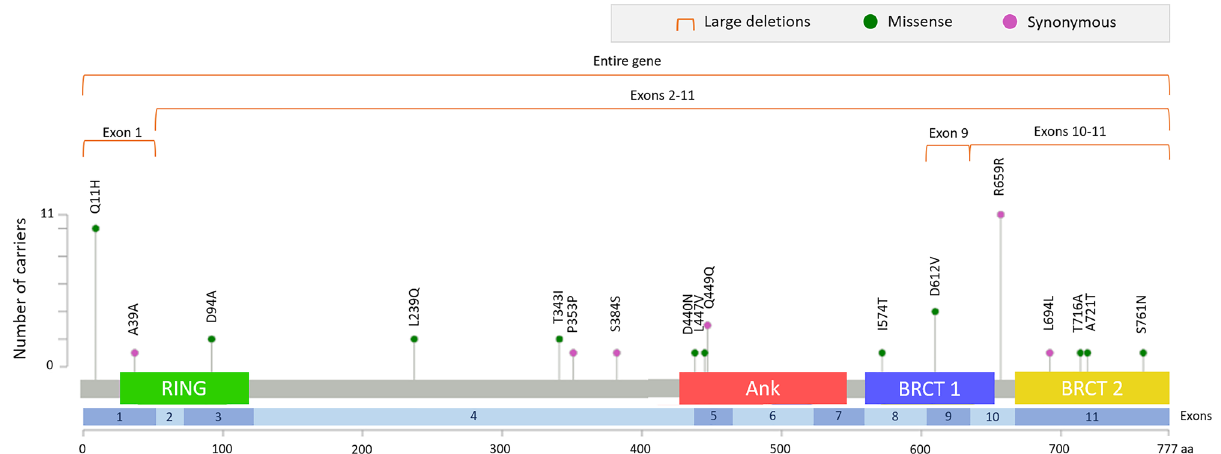
Figure 1. Map of the BARD1 protein domains showing the location of rare germline variants identified in our cohort. The graphic was generated with MutationMapper tool at cBioPortal for Cancer Genomics (https:// cbiop ortal. org/ mutat ion_